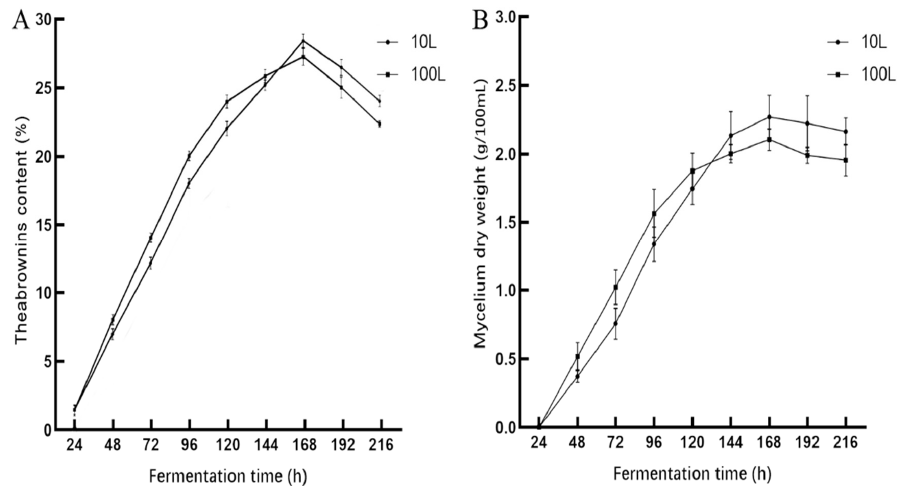
Figure 2. Variation curve of theabrownins content ( A ) and mycelial dry weight ( B ) in a 10 L and 100 L fermentor with fermentation time.